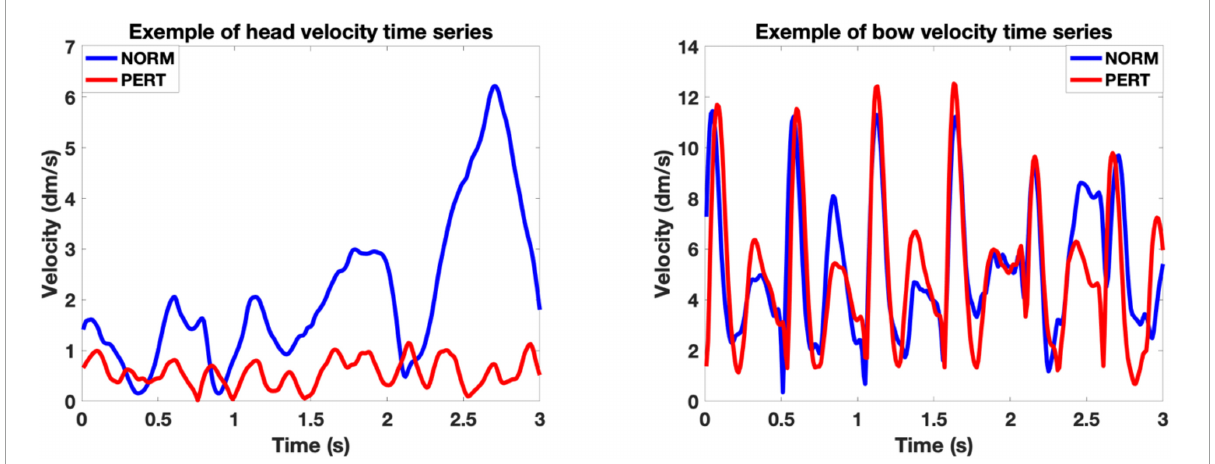
FIGURE3 Representative examples of head (Left) and bow (Right) velocity time series. The examples correspond to a 3-s window of the movement of the first violinist of V1, during the third take in NORM and the third take in PERT with the first conductor, starting at bar 18. In these examples, we can appreciate the periodical nature of both head and bow motion, the similarity of bow motion across conditions and the differences in amplitude and frequency composition of head motion across those conditions. Notice that the Y-scales of the examples of head and bow motion differ, as the possible range of head motion is physiologically restricted compared to the amplitude required by the execution of bow motion.